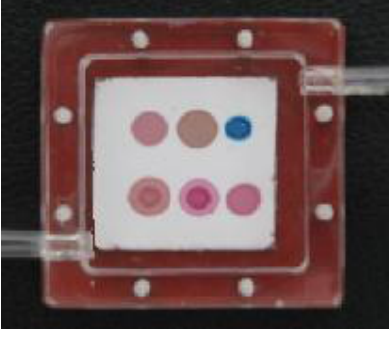
Figure 2. CSA. The dye spots are ZnTPP, ZnOEP, ZnPc, CoTPP, CoOEP and H2OEP, clockwise and sequentially from the top left corner, numbered from 1 to 6. The cartridge has an inner size of 30 × 30 × 10 mm³